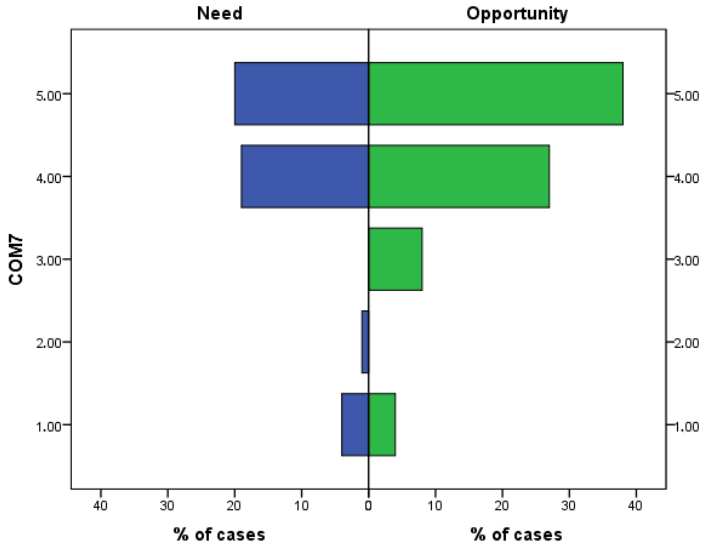
Figure 10. Barplot of COM7 (founders’ technical skills and knowledge) split per need and opportunity.